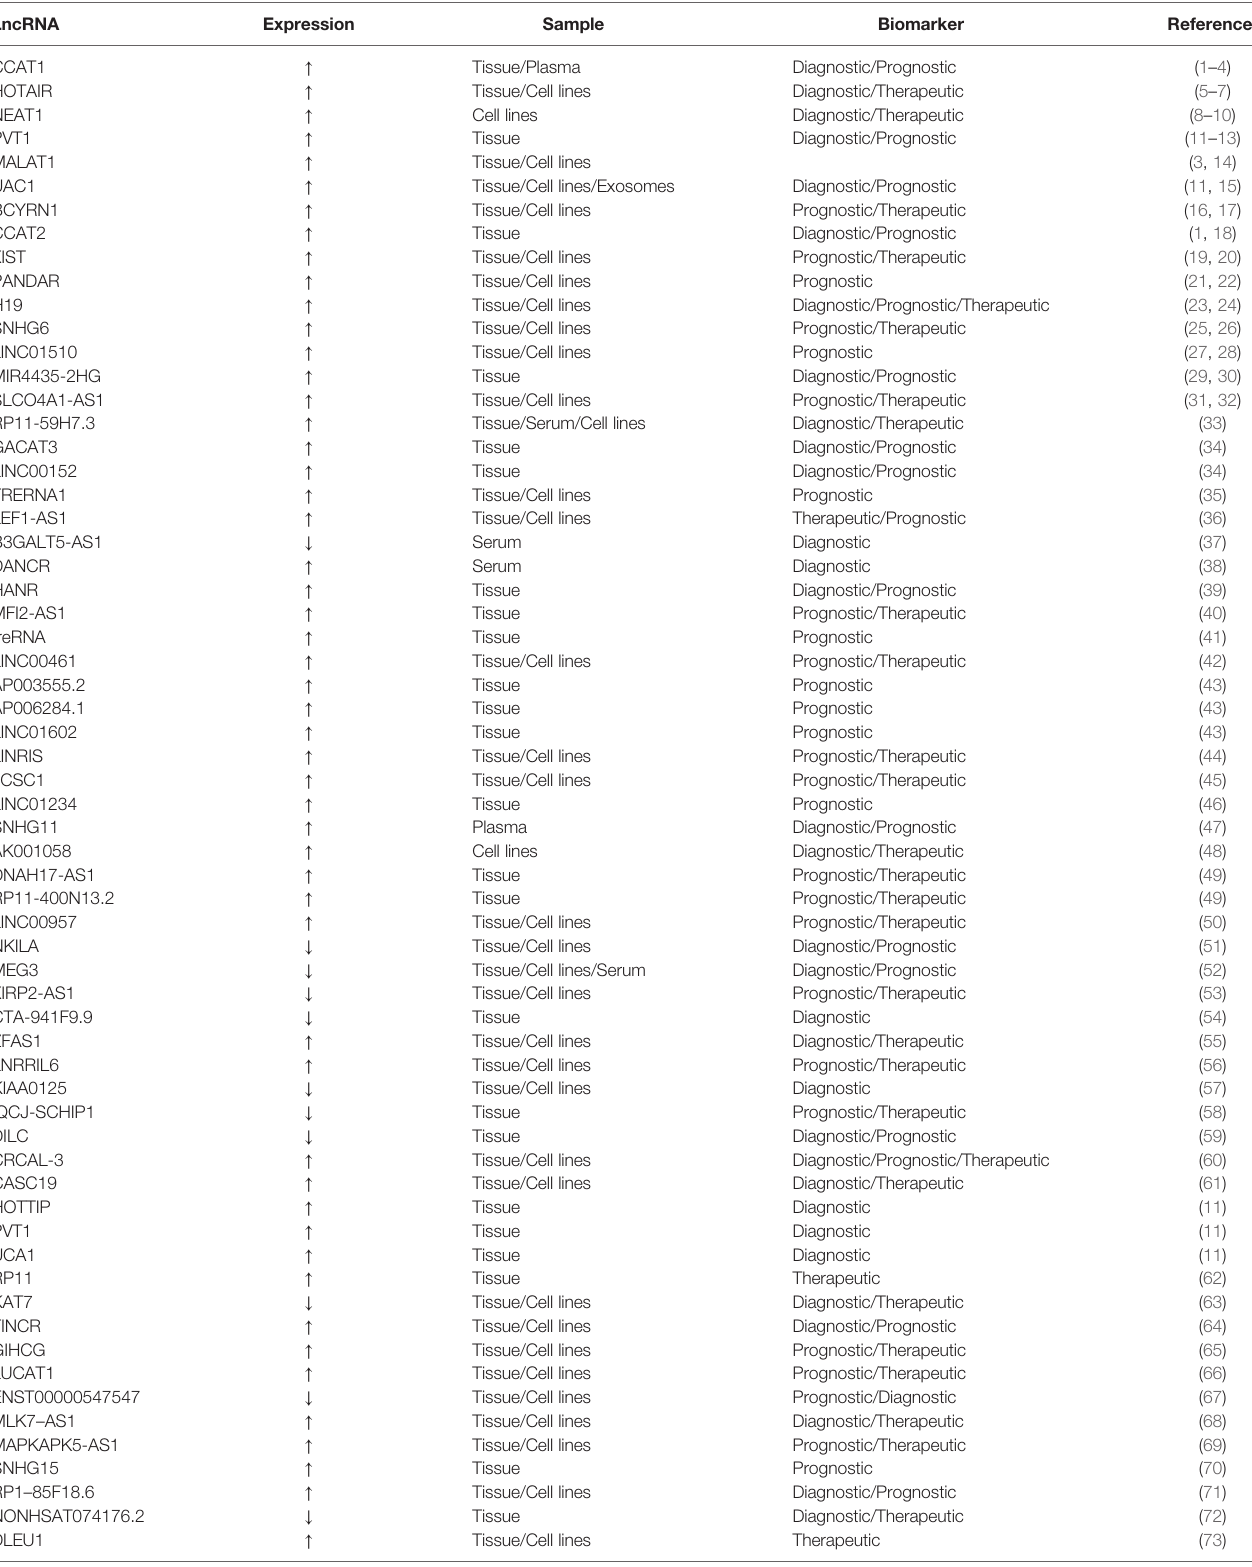
TABLE 2 | Potential long non-coding RNAs as biomarkers for the diagnosis and prognosis of colorectal